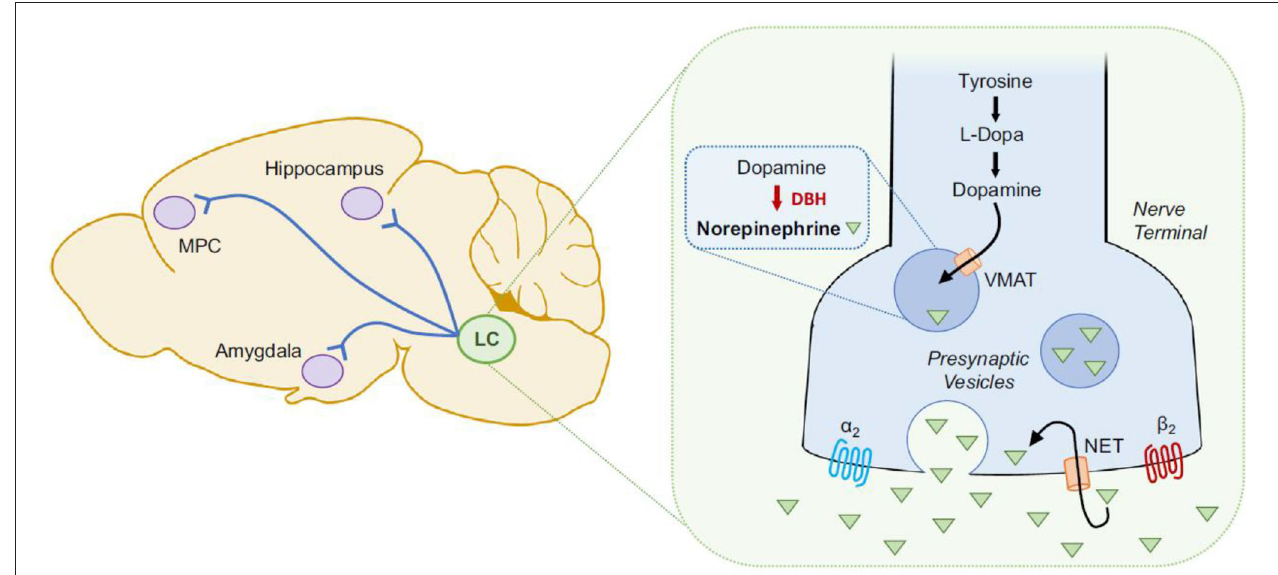
FIGURE 10 | Graphic illustration of norepinephrine (NE) synthesis in the brain of a rodent. Synthesis of NE occurs from tyrosine through the following steps: (a) tyrosine hydroxylase converts tyrosine to levodopa or l-3,4-dihydroxyphenylalanine (L-DOPA); (b) L-type amino acid decarboxylase converts L-DOPA to dopamine; (c) vesicular monoamine transporter (VMAT) transports dopamine into the presynaptic vesicles; and (d) dopamine- β -hydroxylase (DBH) converts dopamine into NE. NE binding to β - and α - adrenergic receptors takes place after its release from the presynaptic vesicles into the synapse, from where norepinephrine transporter (NET) mediates its reuptake. Locus coeruleus (LC) houses the majority of brainstem noradrenergic neurons and it projects to several regions in the brain, including the amygdala, hippocampus and medial prefrontal cortex (MPC) [Reprinted from ( 363); Copyright (2020); with permission from Elsevier; License #